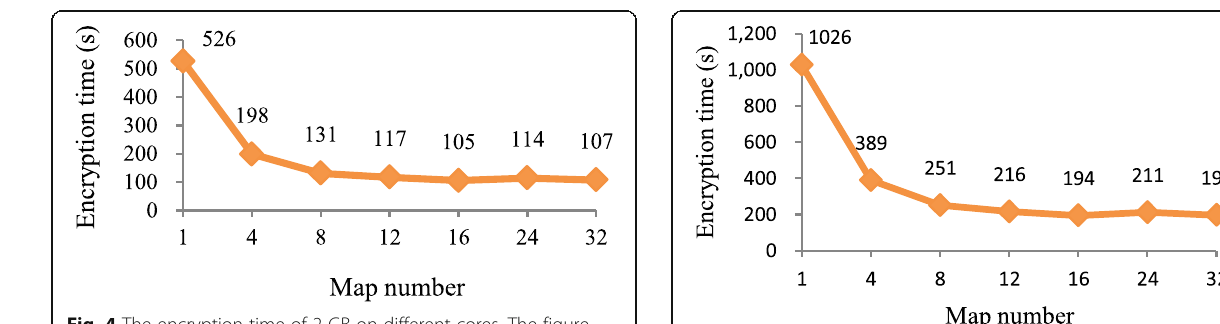
Fig. 4 The encryption time of 2 GB on different cores. The figure shows the encryption time of a 2-GB file allocates to different cores in parallel environments